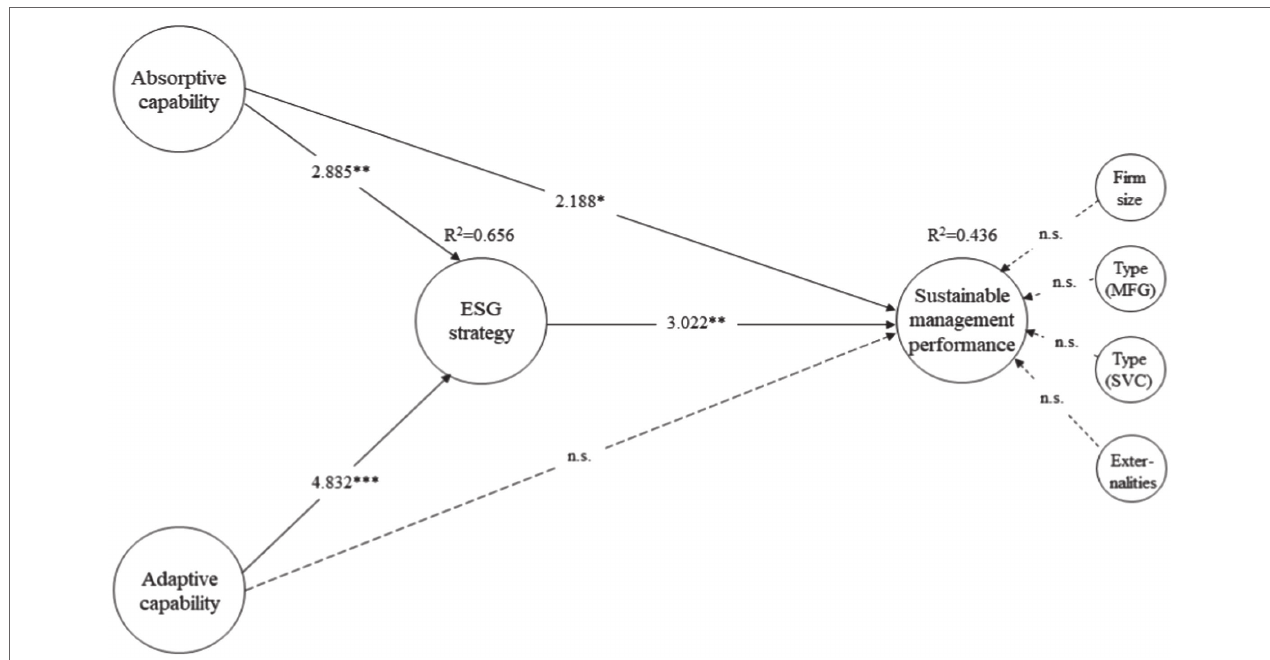
FIGURE 2 | Estimated results of a structural equation analysis. Non-significant paths are shown with a dotted line; n.s. = not significant. * p < 0.05, ** p < 0.01, *** p <